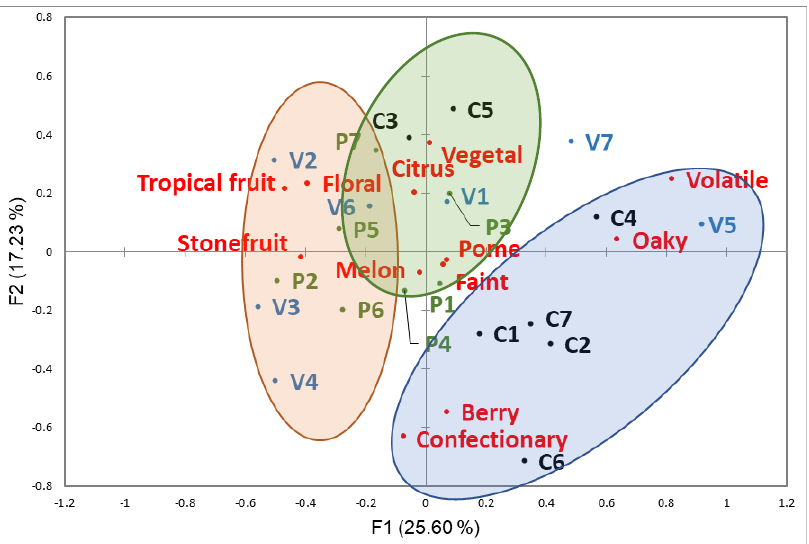
Figure 5. CA map showing trained consumers’ UFP data. Ellipses identify groups according to k-means clustering. Varietal wines are shown in different colors.